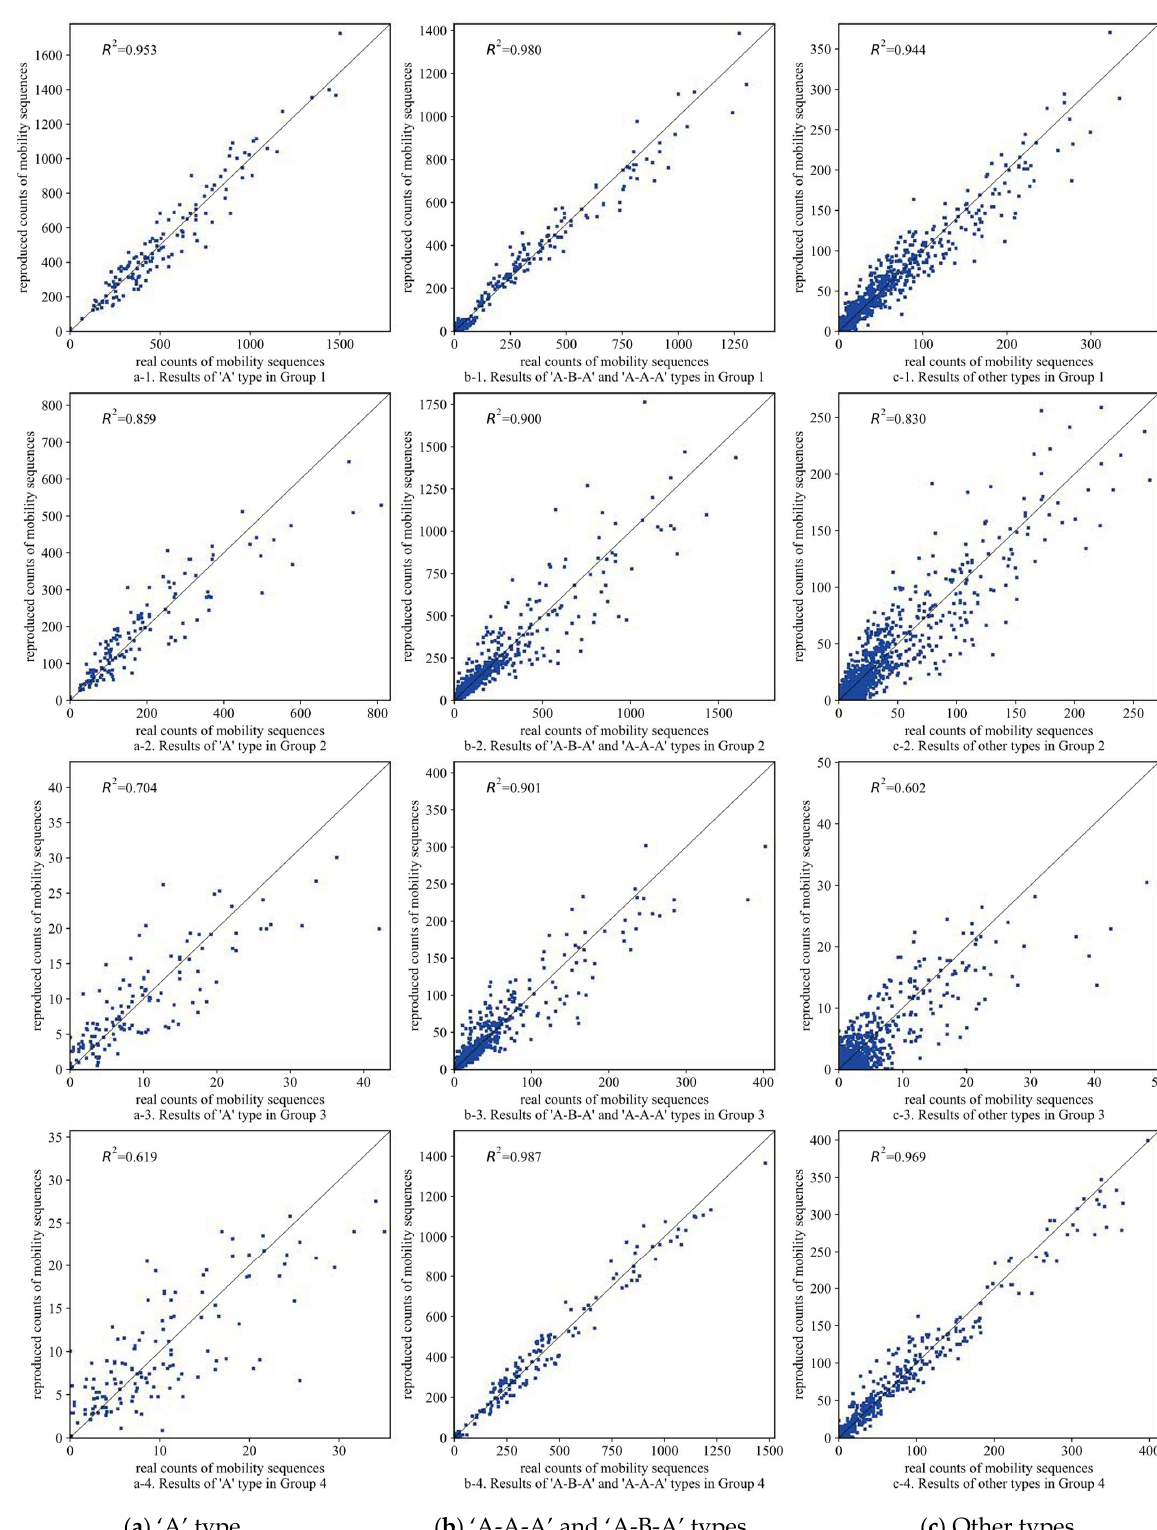
Figure A2. Spatial evaluation for the reproduction results for 1988. ( a ) Results for ‘A’ type; ( b ) Results for ‘A ‐ A ‐ A’ and ‘A ‐ B ‐ A’ types; ( c ) Results for other types.